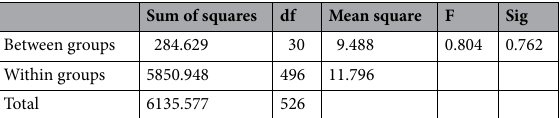
Table 7. One-way ANOVA for Fani latitude.